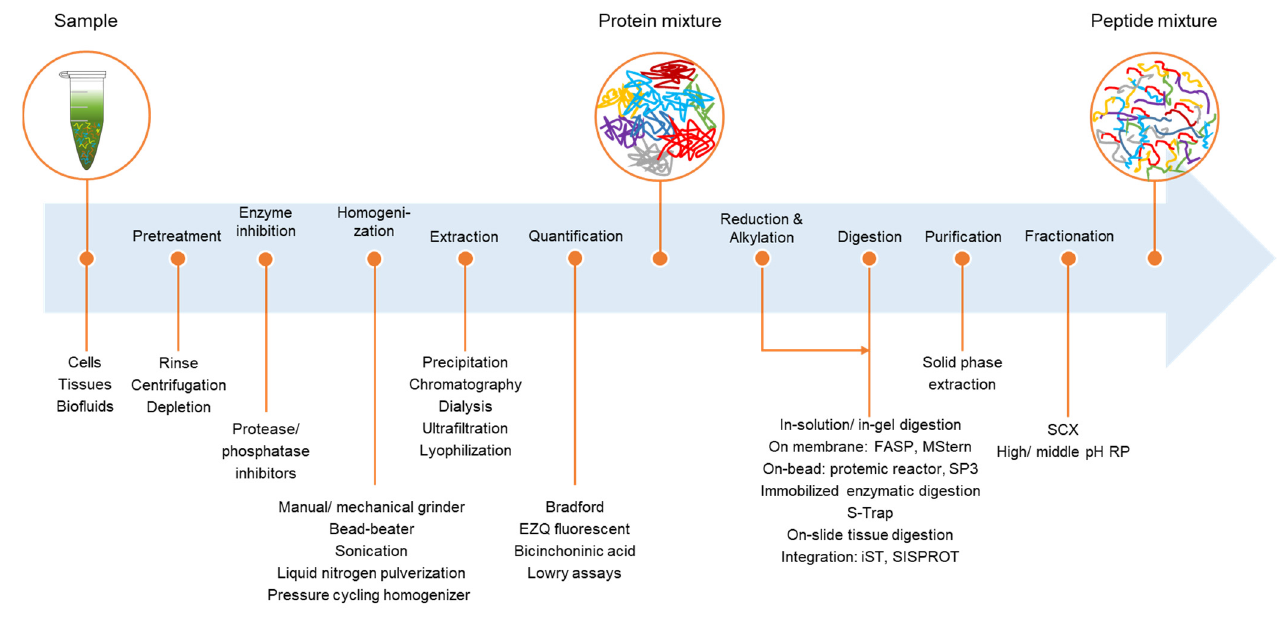
Figure 1. Sample preparation in bottom-up proteomics.